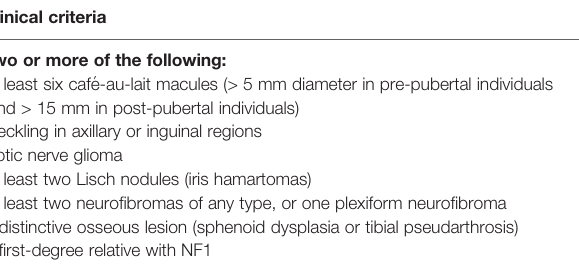
TABLE 1 | Neuro fi bromatosis type 1 (NF1) diagnostic criteria. Adapted from (18). Clinical criteria